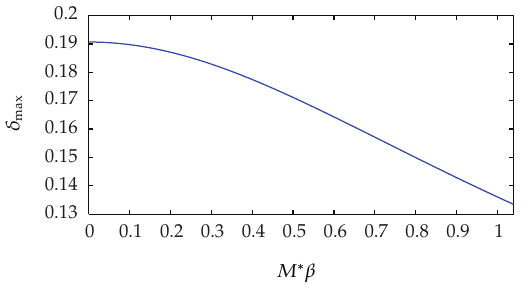
Figure 4: Upper bounds for (cid:8) G (cid:8) when Mβ ∈ (cid:2) 0 , 1 . 0394 (cid:3) .